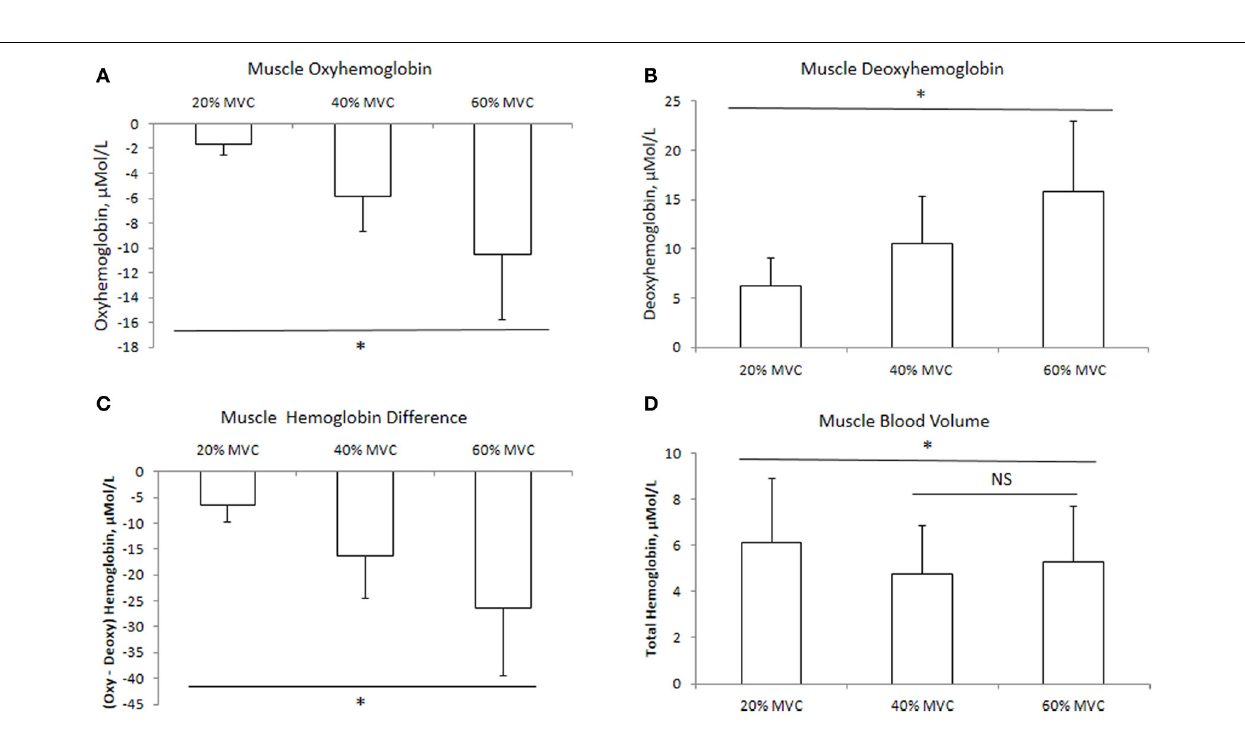
FIGURE 2 | Muscle hemodynamic responses at three different intensities of intermittent isometric contractions of the biceps brachii. ∗ Indicates P < 0 . 05.